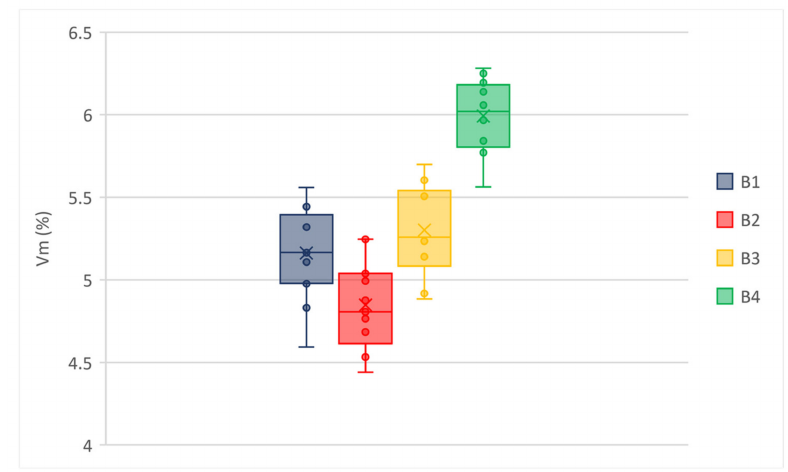
Figure 5. Voids content of binder mixtures.